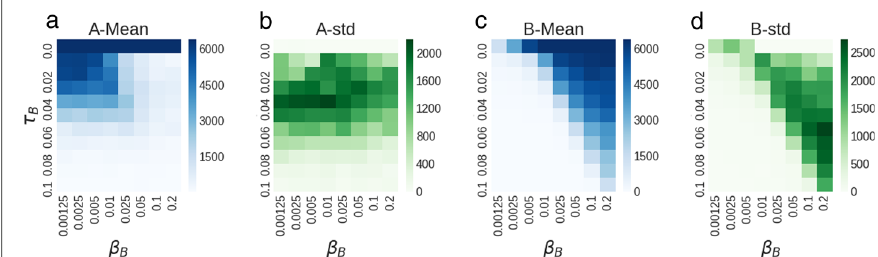
Fig. 5 Heatmaps of diffusion depth and variance for Contagation A and Contagion B . Contagions diffuse on small-world graphs. The x-axes denote β B , the rewiring probability of Contagion B ’s layer, and the y-axes τ B , the dormancy rate of B . Panels ( a ) and ( b ) show the mean and standard deviation of Contagion A ’s diffusion depth. A strong phase transition occurs when τ B is non-zero at τ B = τ A . We fix β A = 0.001, τ A = 0 and β α = 1.0. An inverse relationship between τ B and B exists ( c ) where the greatest instability occurs around = 0.05 and β = τ B B